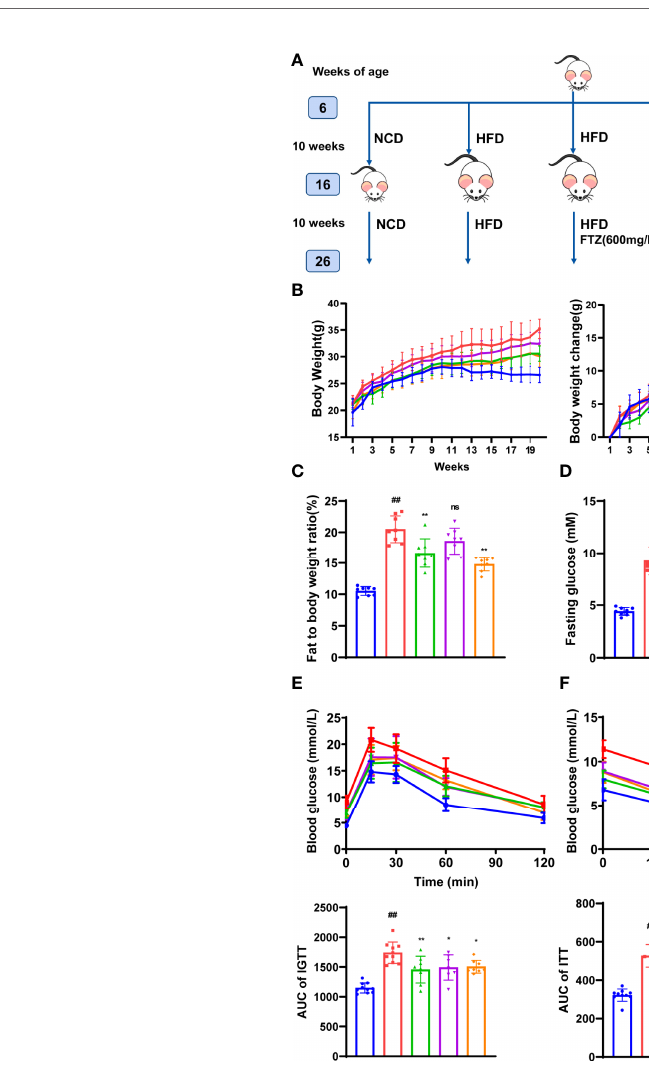
FIGURE 1 | Experimental methods using FTZ and the effects of FTZ on weight gain, obesity, and insulin sensitivity in HFD-induced obese mice. (A) The experimental approach. (B) Fasting body weight of mice at week 20 (n=8-10). (C) Fat-to-body weight ratio (n=8). (D) Fasting insulin (n=8). (E, F) The IPGTT and IPITT assays were performed to evaluate the insulin sensitivity of mice in the indicated groups treated with NCD, HFD, or FTZ (n=7-10). Data are represented as means ± SEM. # indicates a signi fi cant difference between the NCD group and the HFD group (t-test); * indicates a signi fi cant difference between the FTZ (600 mg/ kg)/FTZ (1,200 mg/kg)/ATV (10 mg/kg) group and the HFD group (one-way ANOVA). ## P < 0.01 versus NCD mice; * P < 0.05, ** P < 0.01 versus mice fed by HFD. ns indicates no signi fi